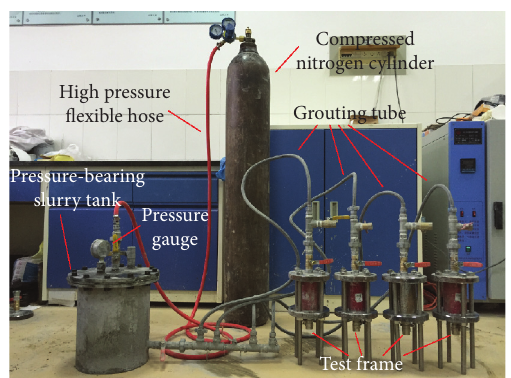
Figure 3: Permeability coefficient measuring device for the grouted